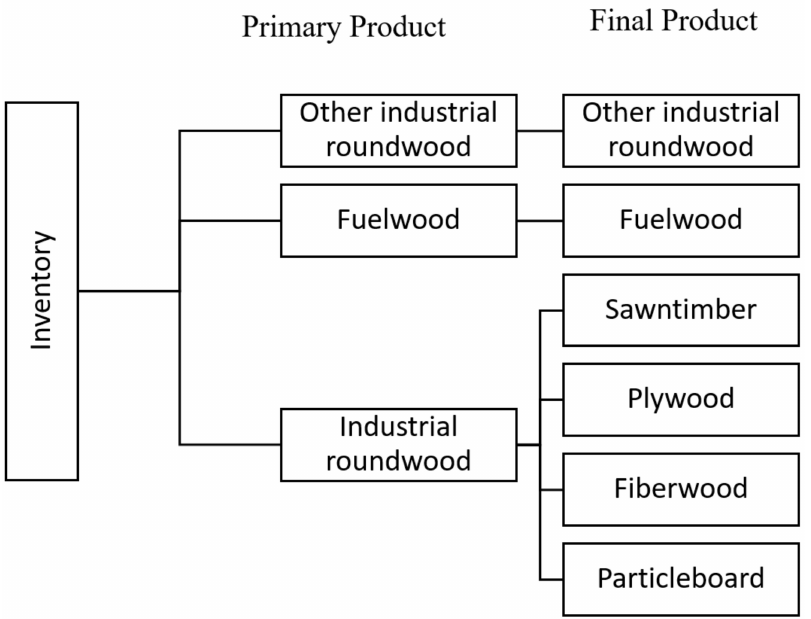
Figure 3. Forest products in GFPM. Adapted from Buongiorno, J., Zhu, S., Zhang, D., Turner, J., and Tomberlin, D. (2003). The global forest products model: structure, estimation, and applications. Elsevier